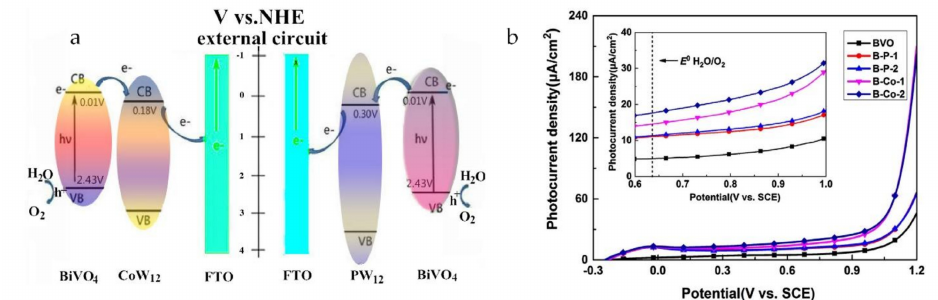
Figure 10. ( a ) Schematic illustrations of charge transfer processes for BiVO 4 /CoW 12 and BiVO 4 /PW 12 electrodes. ( b ) LSV plots of BiVO 4 photoanode, BiVO 4 /PW 12 photoanode, and BiVO 4 /CoW 12 photoanode measured in 0.1M Na 2 SO 4 solution (pH 5.9) under visible light ( λ > 400 nm, 100 mW/cm 2 ) tiny illumination from the front side, the inset is a magnified view of photocurrent curves at the range of 0.6–1.0 V [111].